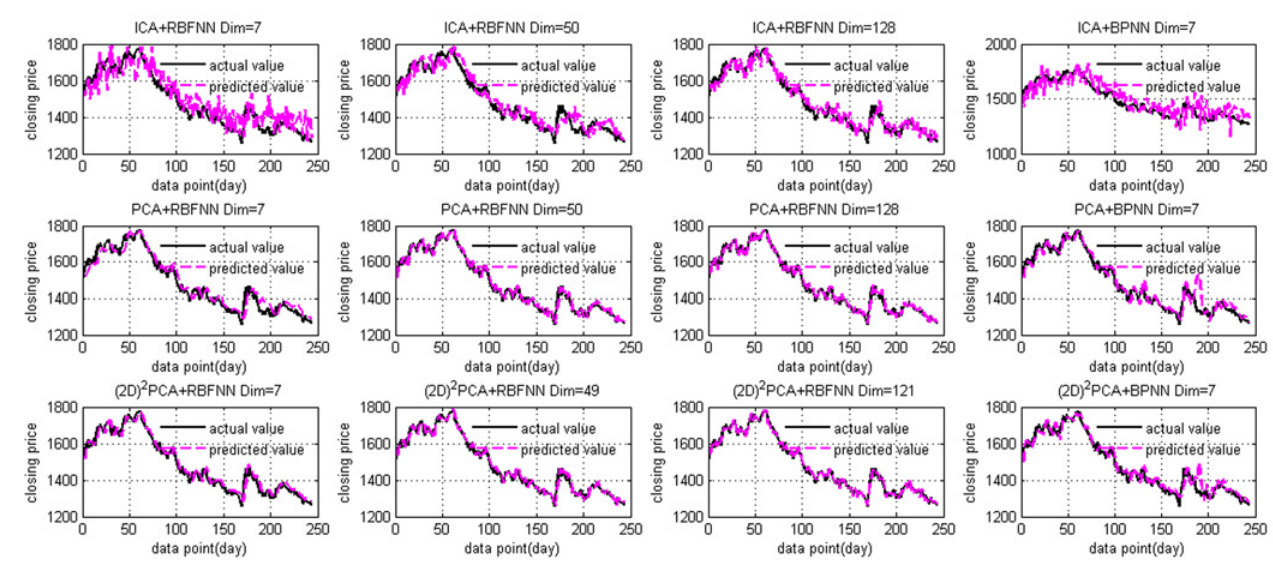
Fig 5. Fitting curve of prediction results and the actual data. The red and black colored curves indicate the prediction results and actual data, respectively. The top, middle and bottom row display the prediction results of ICA, PCA and (2D) 2 PCA associated with RBFNN (Dim = 7,50,128) and BPNN (Dim = 7),